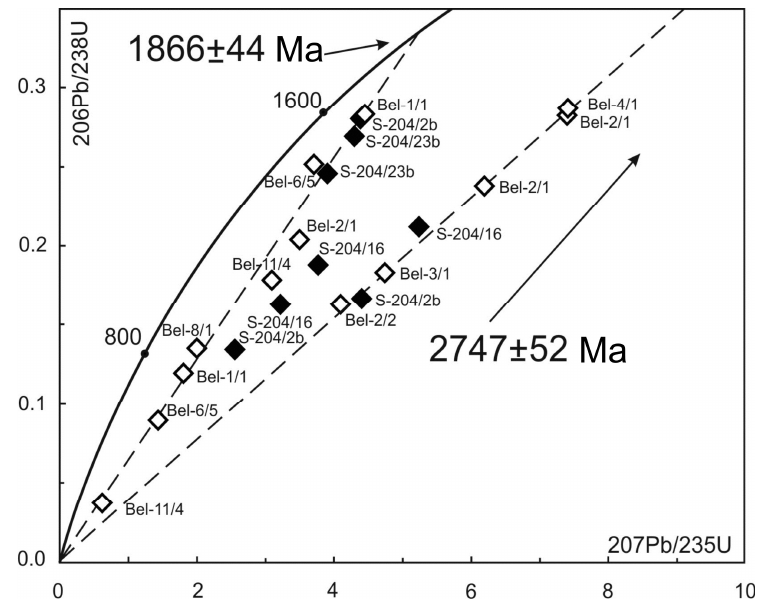
Figure 1. U–Pb diagram for garnets from eclogites of BMB (modified after [9]). Filled diamonds are garnets from Salma eclogites, white diamonds are garnets from Gridino eclogites.